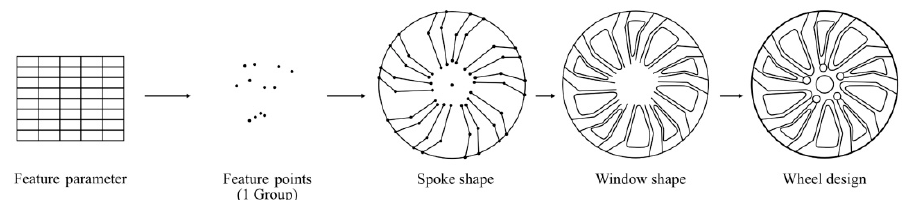
Figure 8. Shape transformation process. The transformation model reduces the feature values to a set of feature points. Spoke edges are constructed from the relationships between the feature points. The spoke edges and the rim together form the window construction area, which is shaped according to the offset values.